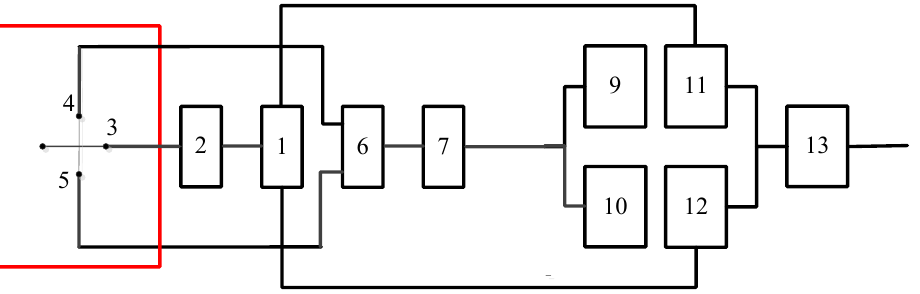
Figure 2. Functional diagram of the device.